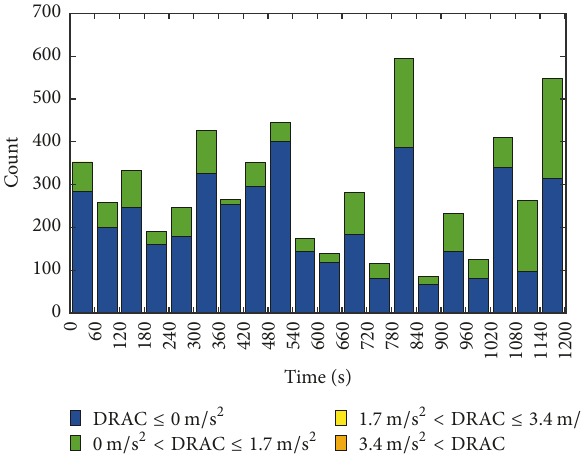
Figure 9: DRAC values categorized in four groups over the considered time interval in lane 2.